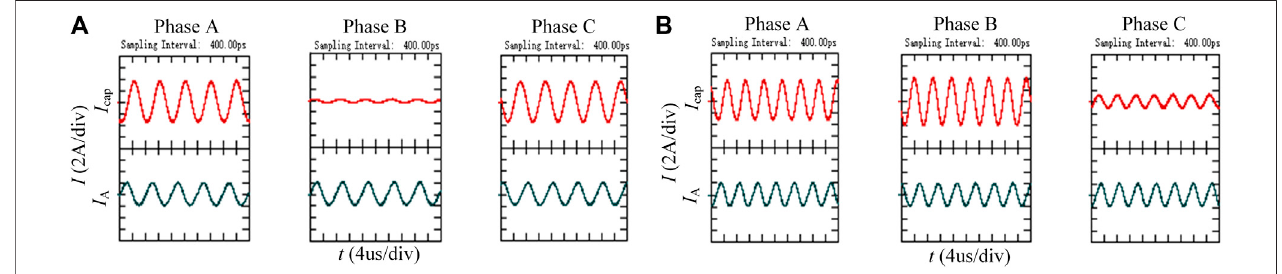
FIGURE 11 | Capacitor current waveform in different phases (A) When harmonic source frequency is f 2 (122 kHz) (B) When harmonic source frequency is f 1 (160 kHz).